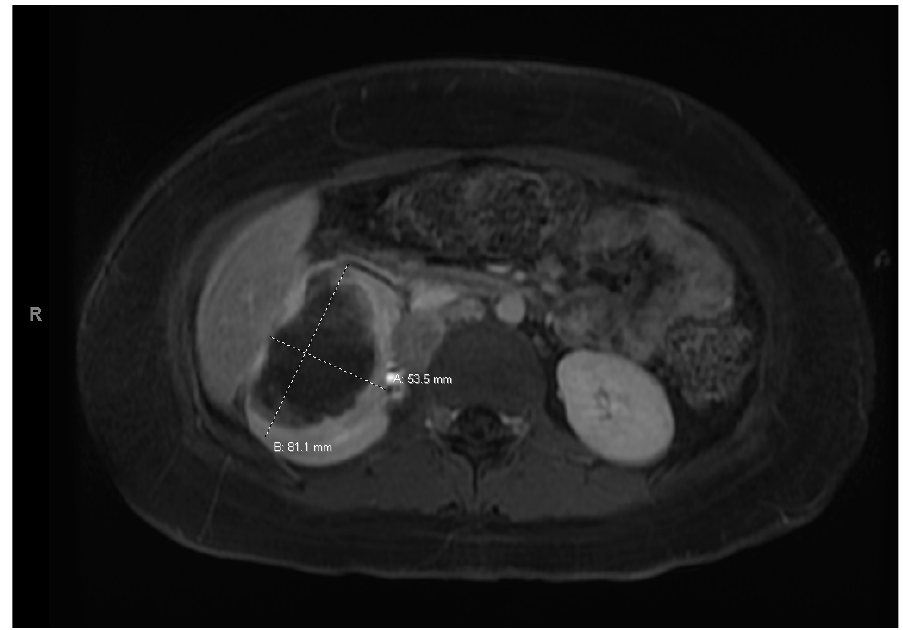
Figure 3. Left adrenal nodule.